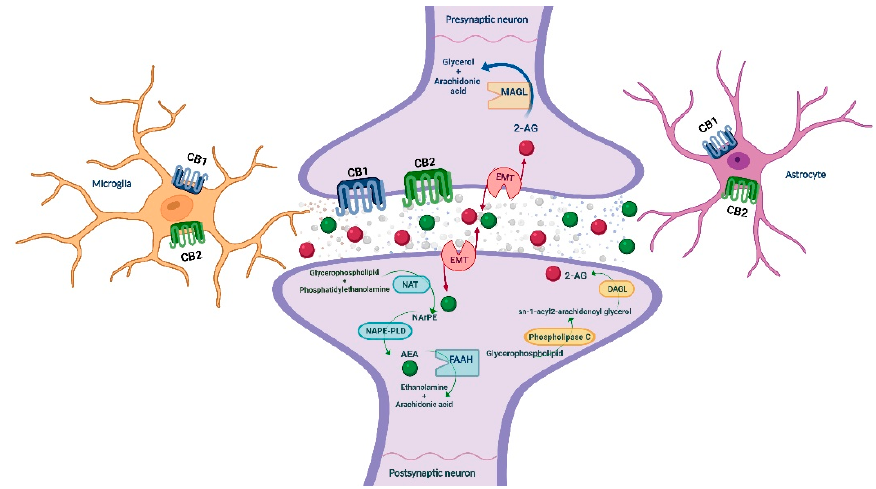
Figure 1. Schematic representation of the main ECS components, including the metabolizing routes of the eCBs. AEA: anandamide; CB1/CB2: cannabinoid receptors 1 and 2; DAGL: diacylglycerol lipase; EMT: endocannabinoid membrane transporter; FAAH: fatty acid amide hydrolase; MAGL: monoacylglycerol lipase; NAPE-PLD: N-acylphosphatidylethanolamine specific phospholipase D; NArPE: N-arachidonoyl phosphatidylethanolamine; NAT: N-acyl transferase; 2-AG: 2-arachidonoylglycerol. Image created with BioRender.